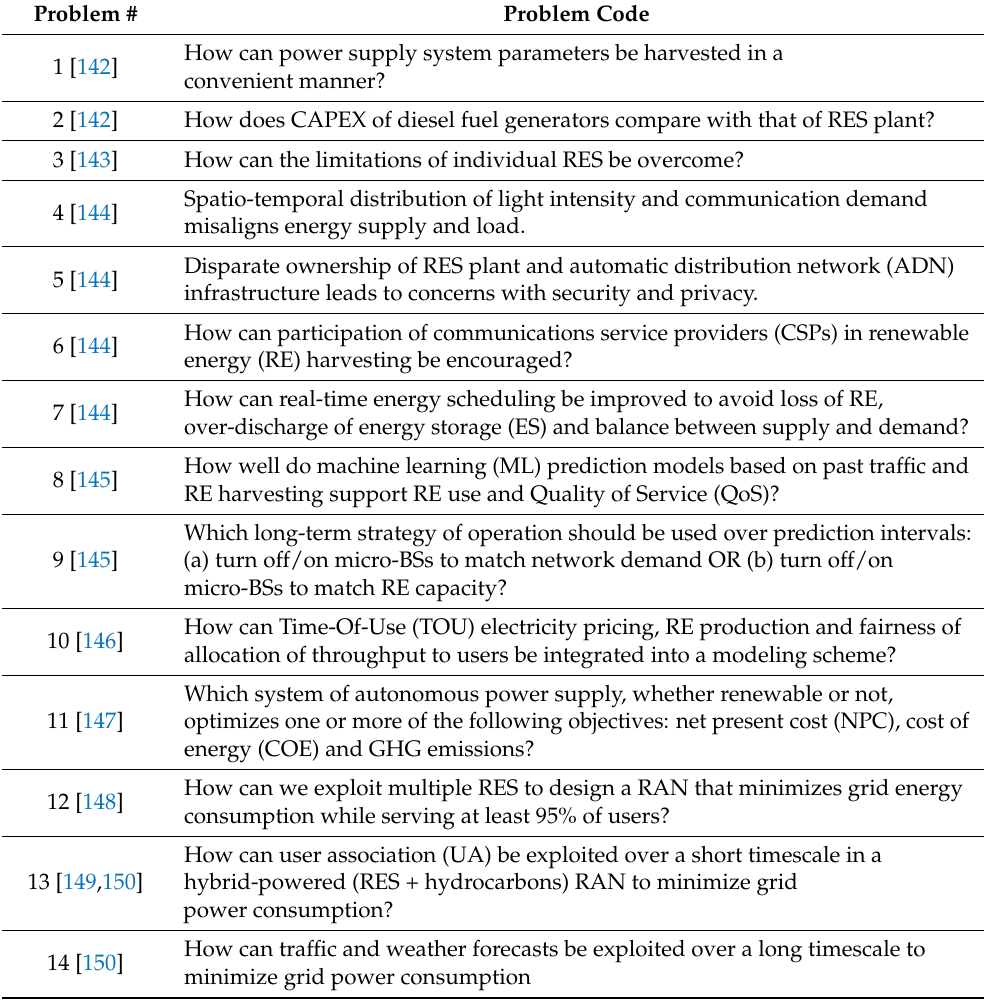
Table A1. Challenges and representative challenge questions.